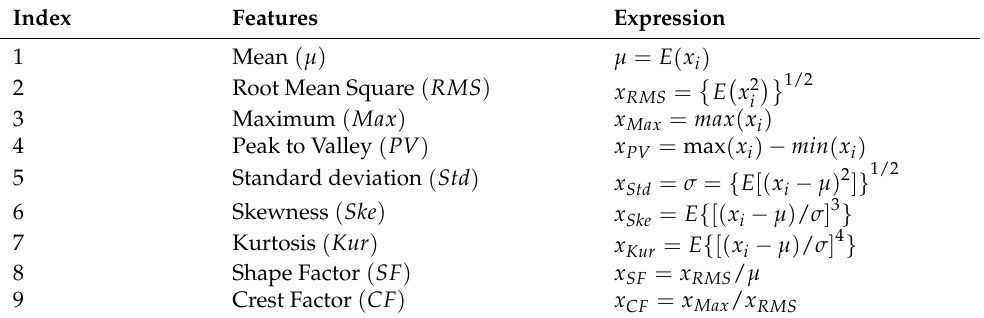
Table 4. The extracted time domain